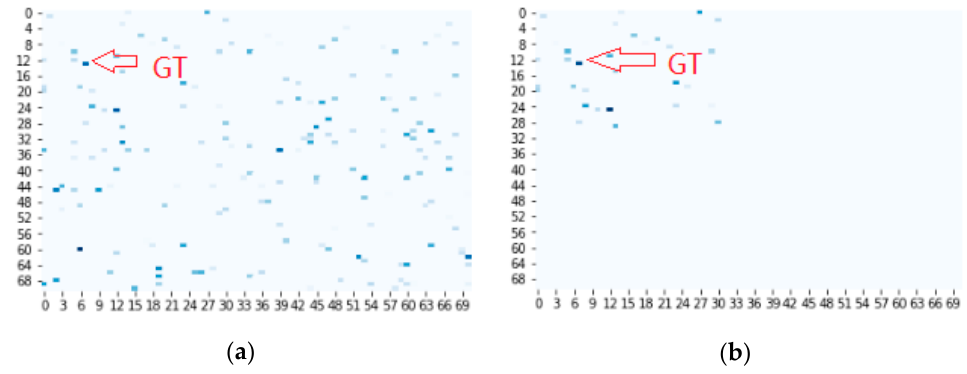
Figure 24. Coarse matching ( a ) and refined matching ( b ) The blue dots indicate the candidate points for localization, and the dark color means that the coarse matching error was small. lapel points can greatly improve the localization accuracy.